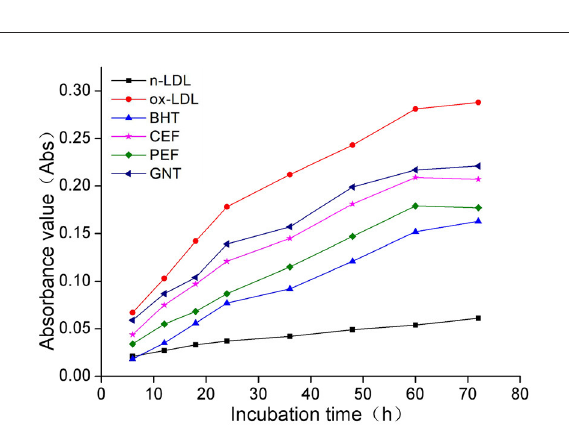
FIGURE9 Kinetic curves of the TBARS generation and degradation in different oxidation incubation